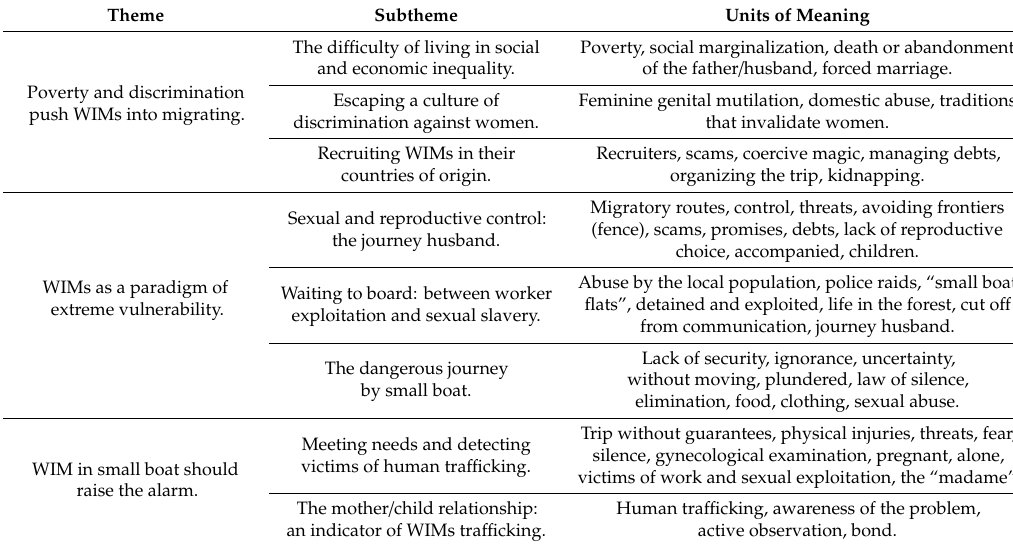
Table 3. Themes, subthemes, and units of